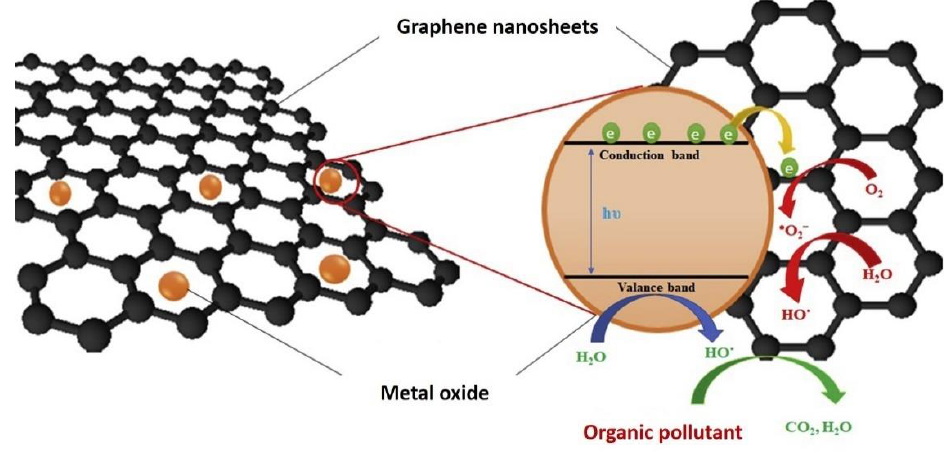
Figure 1. Schematic diagram of the hybrid graphene/metal oxide nanocomposite for toxic gas detection. Reproduced from ref. [43].